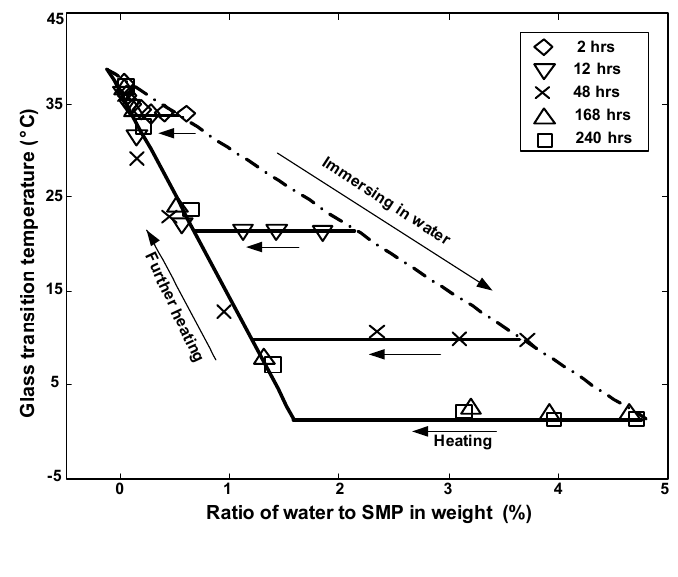
versus ratio of water to shape memory polymer (SMP) in wt %. (Reproduced Figure 8. T g with permission from [101]. Copyright 2005 American Institute of